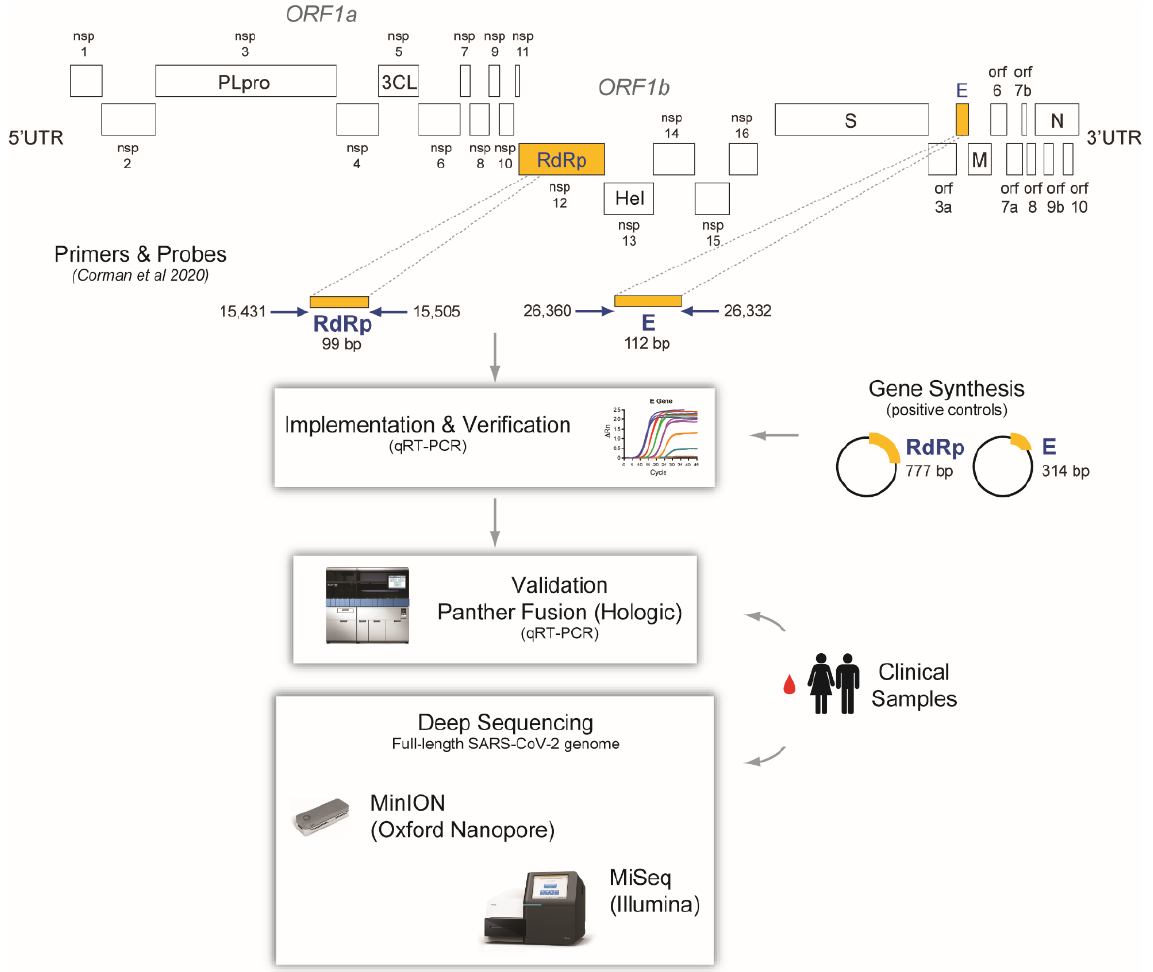
Figure 1. Overview of the implementation and validation of the RT-qPCR SARS-CoV-2 diagnostic test and characterization of the first COVID-19 cases in the South Island, New Zealand. Primers and probes, targeting small regions in the RNA-dependent RNA polymerase (RdRp) and envelope (E) SARS-CoV-2 genes were obtained from Corman et al. [8]. Two fragments corresponding to the RdRp (777 bp, position 14,902 to 14,946; Wuhan-Hu-1 NC045512) and the E (314 bp, position 26,245 to 26,265; Wuhan-Hu-1 NC045512) SARS-CoV-2 genes were synthesized and cloned into the pBluescript II KS(+) plasmid (GenScript Biotech, Singapore) to be used as controls. Primers, probes, plasmid controls, and clinical samples were used to implement and validate the molecular test in the Hologic Panther Fusion ® System. The whole genome of the viruses corresponding to the first two SARS-CoV-2 infections identified in the South Island was characterized using both MinION (Oxford Nanopore Technologies, Oxford, UK) and MiSeq (Illumina, San Diego, CA, USA) deep sequencing platforms. 5 (cid:48) UTR, 5 (cid:48) untranslated region; nsp1 to 16, non-structural proteins 1 to 16; ORF1a to 10, open reading frame 1a to 10; PLpro, papain-like protease; 3CL, 3C-like protease; RdRp, RNA-dependent RNA polymerase; Hel, helicase; S, spike;